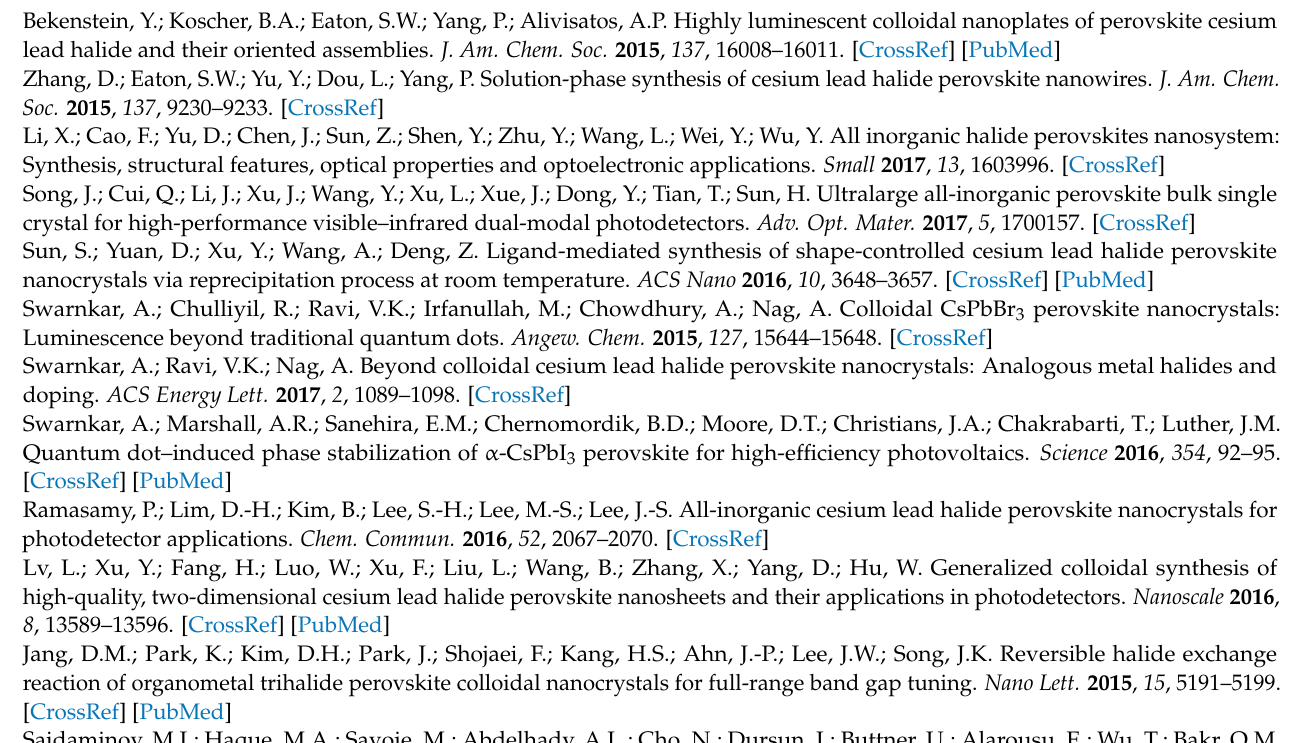
Figure S2: Energy dispersive spectroscopy (EDS) of Figure 3b; Figure S3: X-ray diffractometer